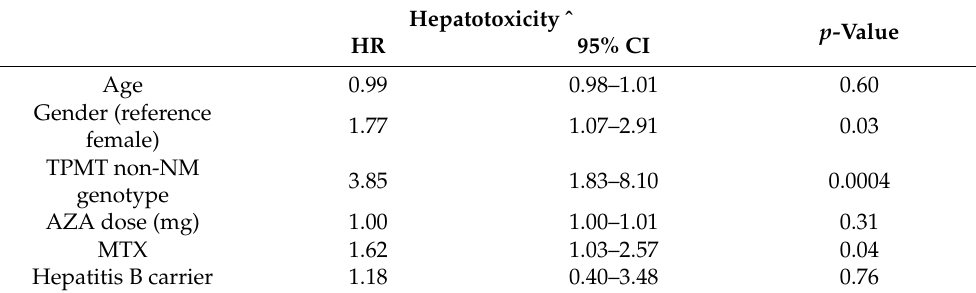
Table 3. Cox regression analysis of risk factors for hepatotoxicity following AZA treatment.